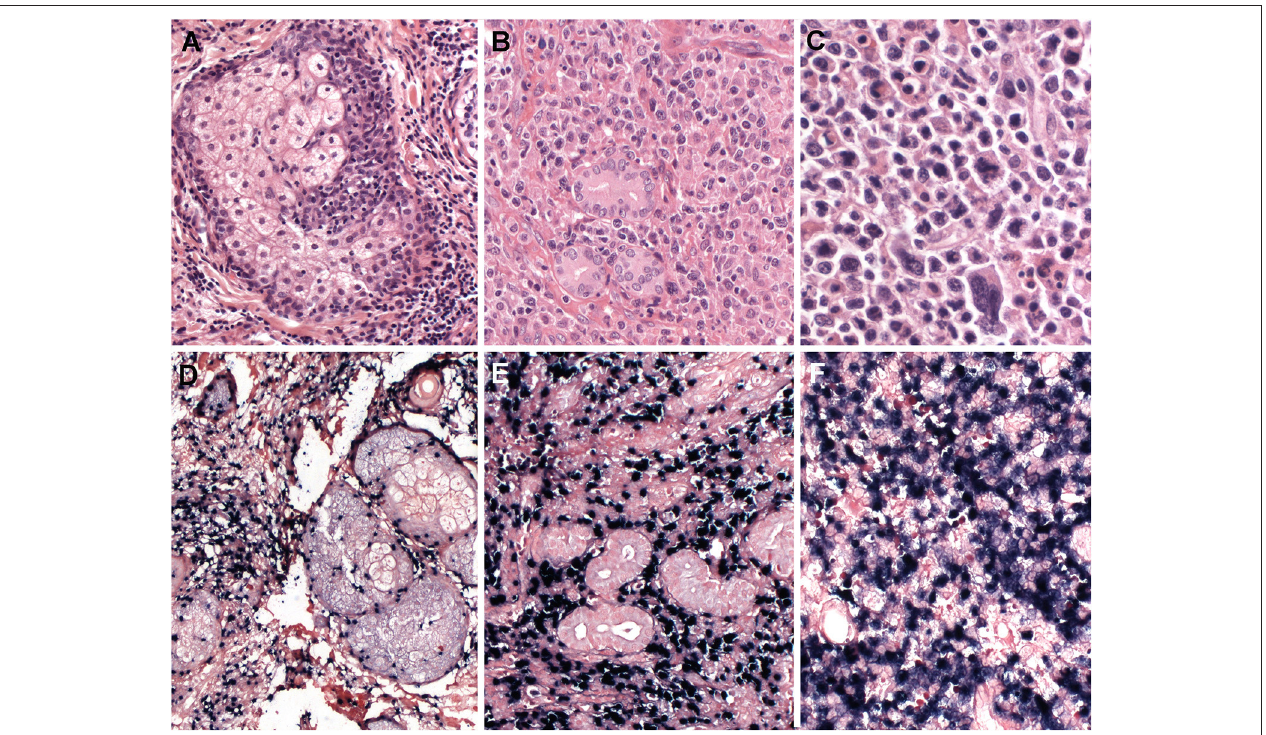
FIGURE 5 | Extranodal, NK/T-cell lymphoma, nasal type. (A–C) Nasal biopsies displaying the morphological spectrum of ENKTCL. (A) Infiltrate of small lymphoid cells with bland cytology surrounding the sebaceous gland, mimicking a reactive lesion (H&E, 400 × ); (B) Dense lymphoid infiltrate of intermediate-sized cells, showing nuclear irregularity and pale to clear cytoplasm (H&E, 400 × ); (C) Atypical cell infiltrate, of pleomorphic large cells admixed with intermediate-sized cells (H&E, 400 × ); (D–F) Lymphoma cells are positive for EBV-encoded small RNA in situ hybridization (EBER, 400 ×